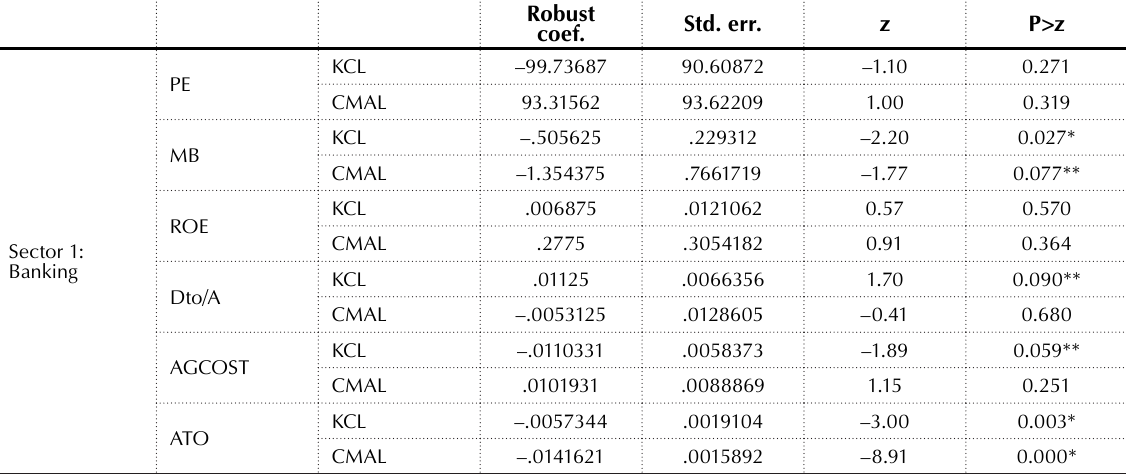
Table 7. GLS panel data regression for the banking sector